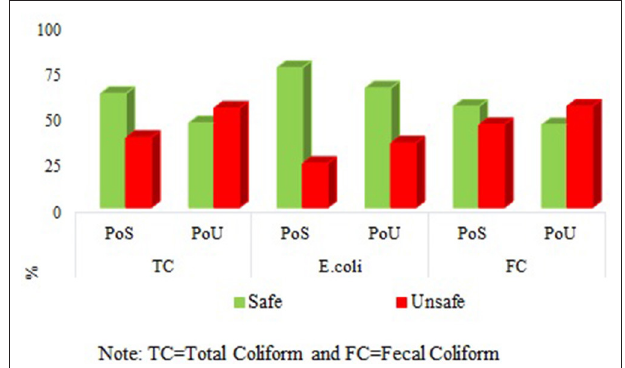
FIGURE 2 | Contamination pathway of Coliform bacteria from PoS to PoU. TC, Total Coliform; FC, Fecal Coliform.